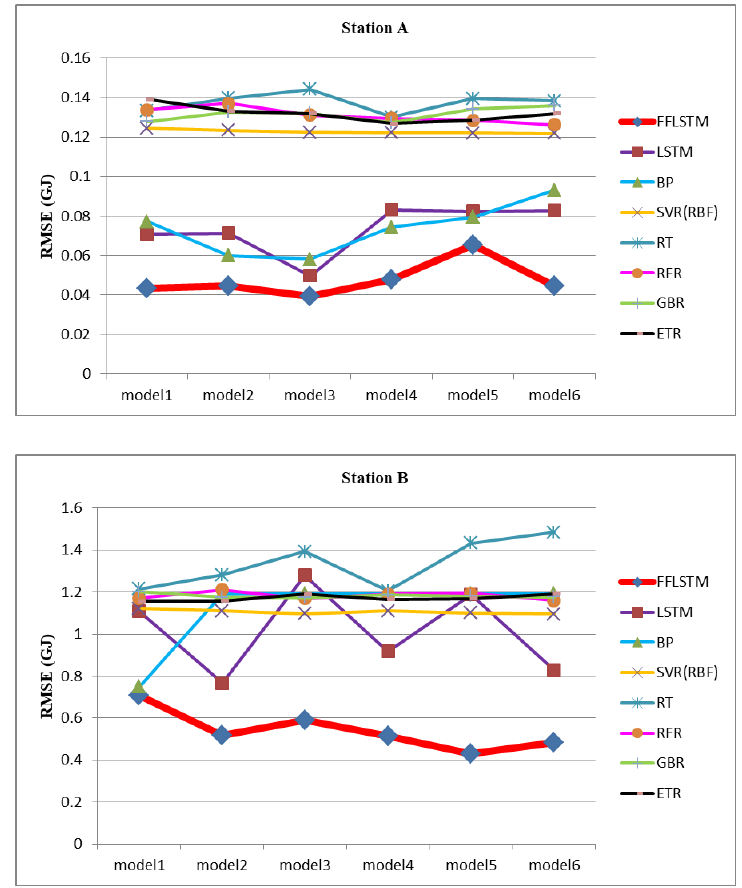
Figure 4. Evaluation of the results of the root-mean-square error (RMSE) for station A and B, respectively.